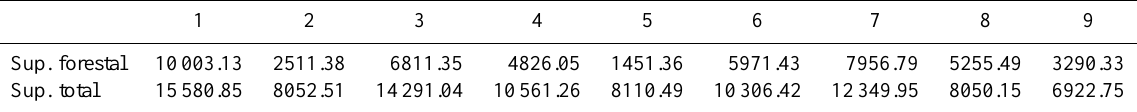
Table 1. Forest surface of the province of Castile and Leon (km 2 ).